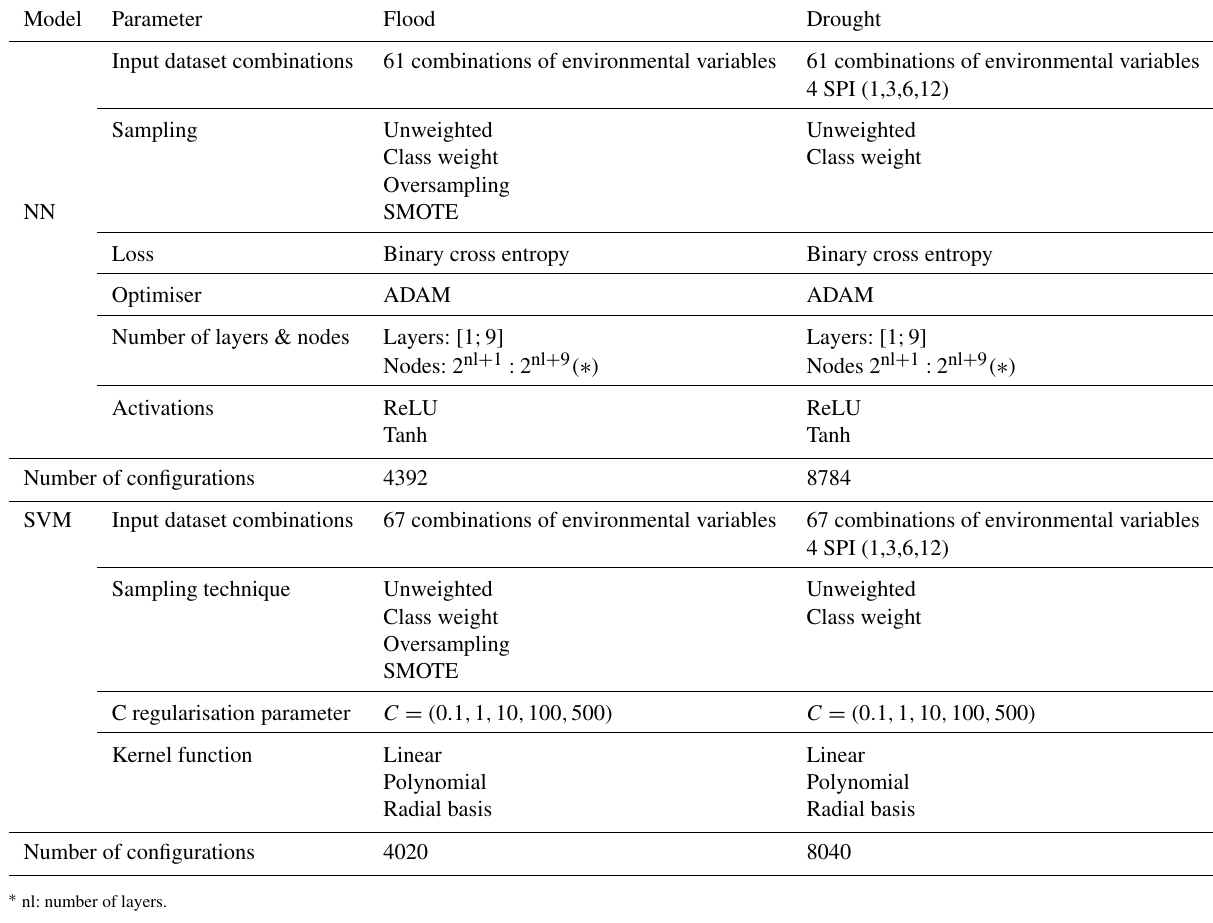
Table 6. Breakdown of all the configuration explored by algorithm and type of hazard. Model